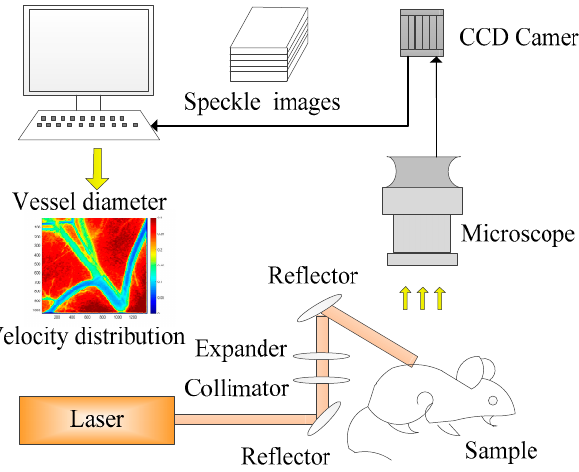
Figure 1. Schematic of laser speckle imaging experimental system.